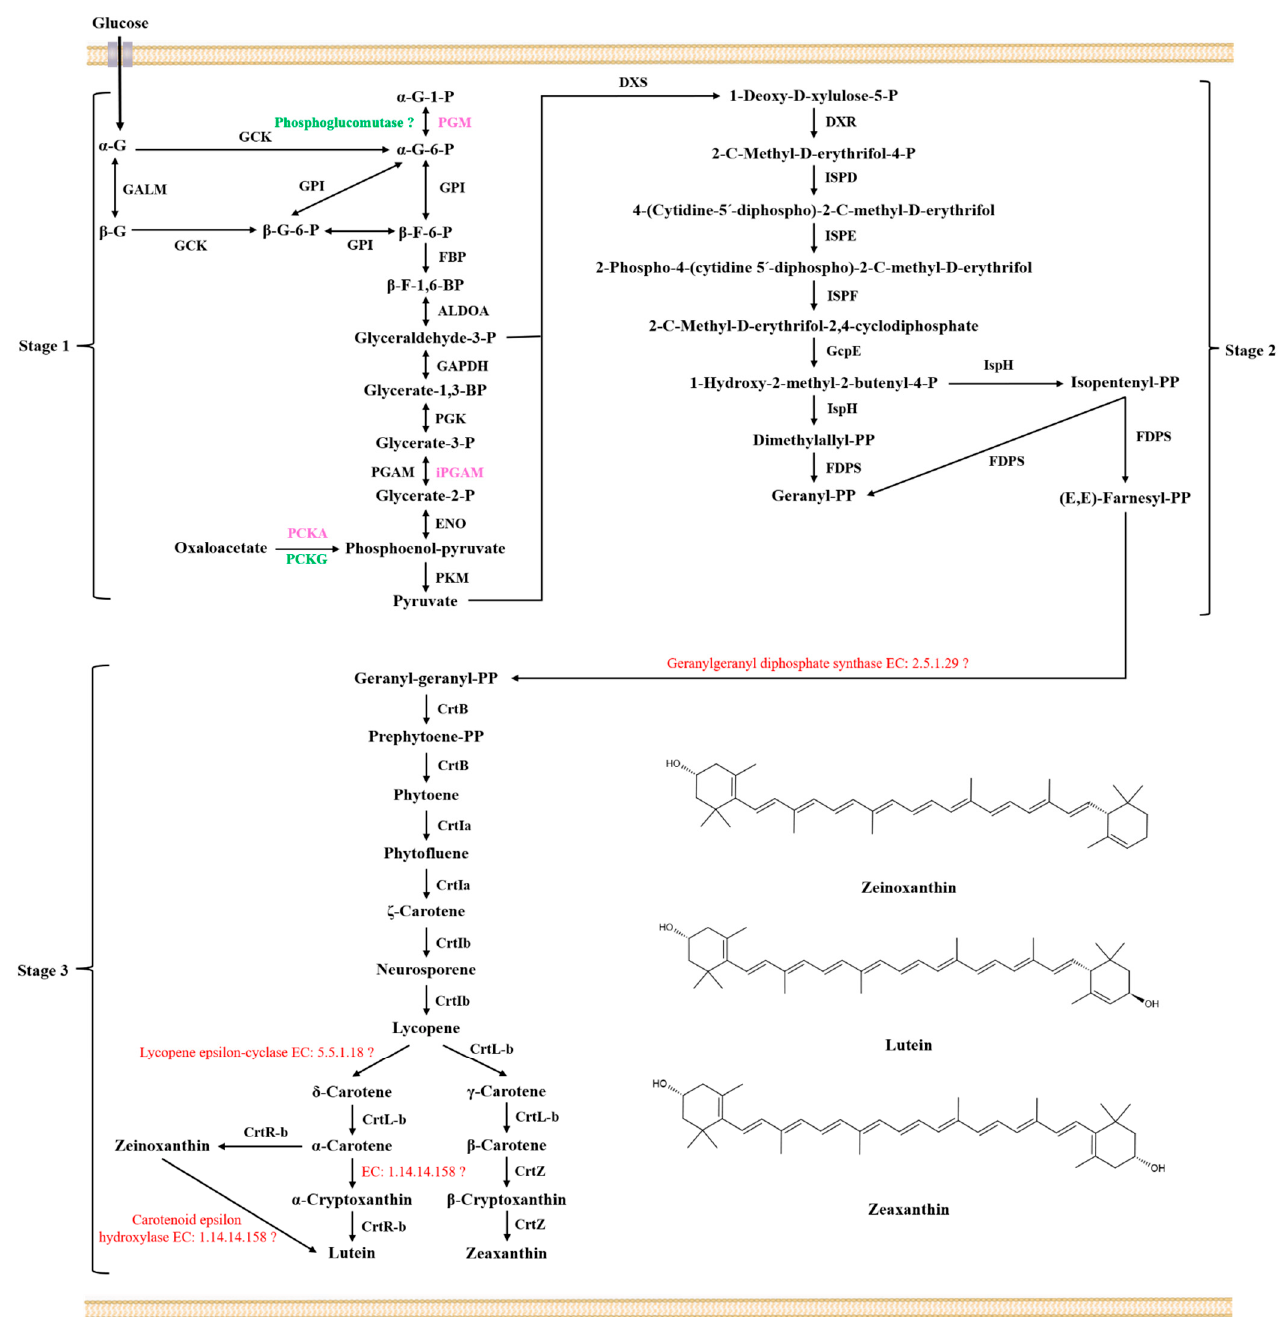
Figure 4. The proposed biosynthetic pathway of MP of Sphingomonas morindae sp. NBD5 and Sphingopyxis sp. USTB-05. α -G-1-P: α -D-glucose 1-phosphate; PGM: phosphoglucomutase; α -G-6-P: α -D-glucose 6-phosphate; GCK: glucokinase; α -G: α -D-glucose; GALM: aldose 1-epimerase; β -G: β -D-glucose; β -G-6-P: β -D-glucose 6-phosphate; GPI: glucose-6-phosphate isomerase; β -F-6-P: β - D-fructose 6-phosphate; FBP: fructose bisphosphatase; β -F-1,6-BP: β -D-fructose 1,6-bisphosphate; ALDOA: fructose bisphosphate aldolase; Glyceraldehyde-3-P: Glyceraldehyde-3-phosphate; GAPDH: glyceraldehyde-3-phosphate dehydrogenase; Glycerate-1,3-BP: Glycerate-1,3-bisphosphate; PGK: phosphoglycerate kinase; Glycerate-3-P: Glycerate-3-phosphate; PGAM: cofactor dependent phospho- glycerate mutase; iPGAM: cofactor independent phosphoglycerate mutase; Glycerate-2-P: Glycerate- 2-phosphate; ENO: phosphopyruvate hydratase; PCKA: phosphoenolpyruvate carboxykinase; PCKG: phosphoenolpyruvate carboxykinase; PKM: pyruvate kinase; DXS: